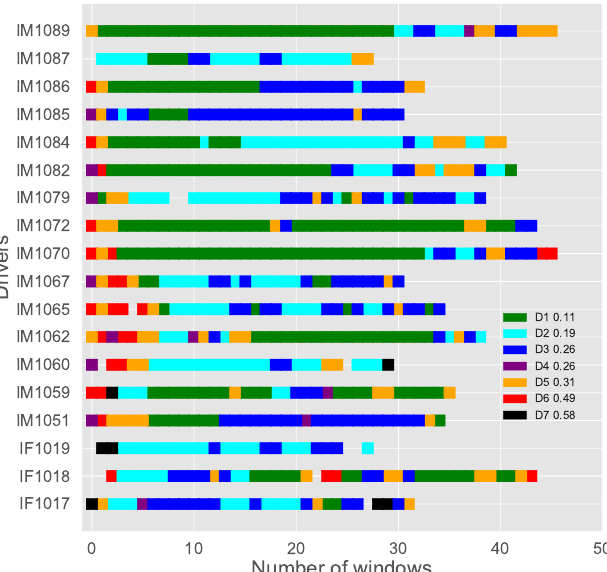
Figure 10. Temporal evolution of the cluster assignments of all drivers for Solution 2 clusters. Each horizontal bar represents a driver, starting with IF1017 and ending with IM1089. Each bar is composed of a number of windows, depending on how fast they completed the route. By observing the order of the assigned clusters, we can assume the nature of the road and observe how each driver approaches the